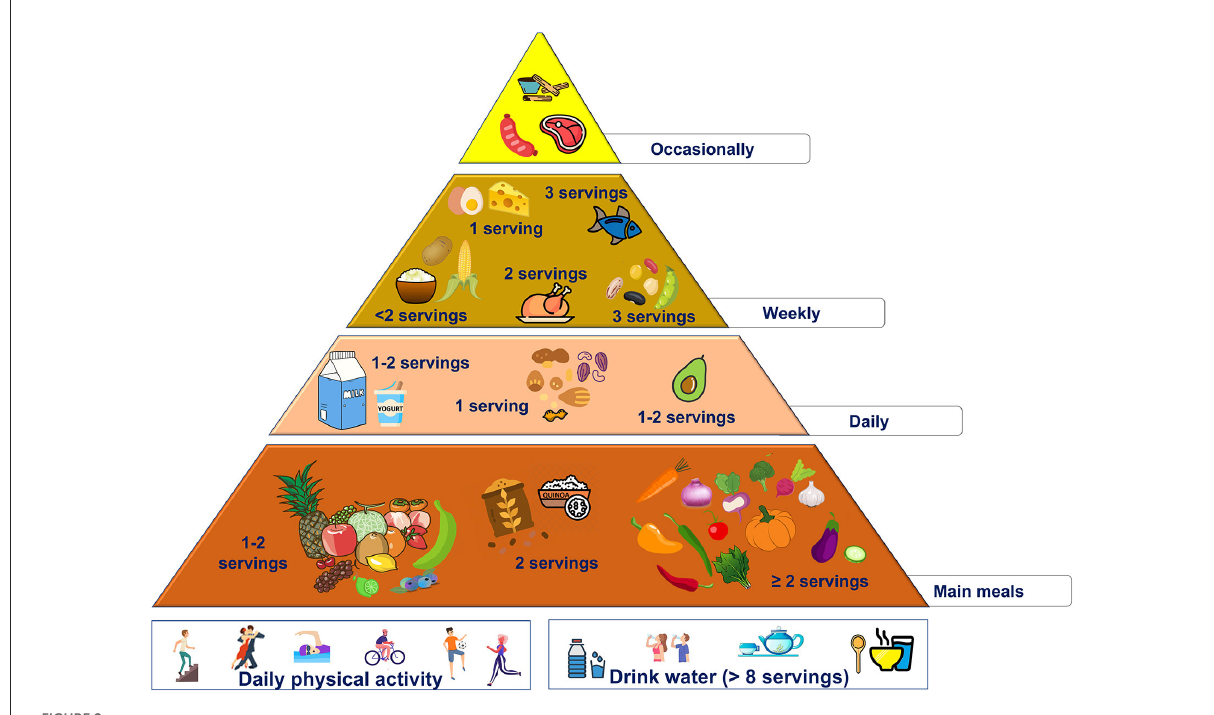
FIGURE2 Proposed nutritional pyramid for Latin